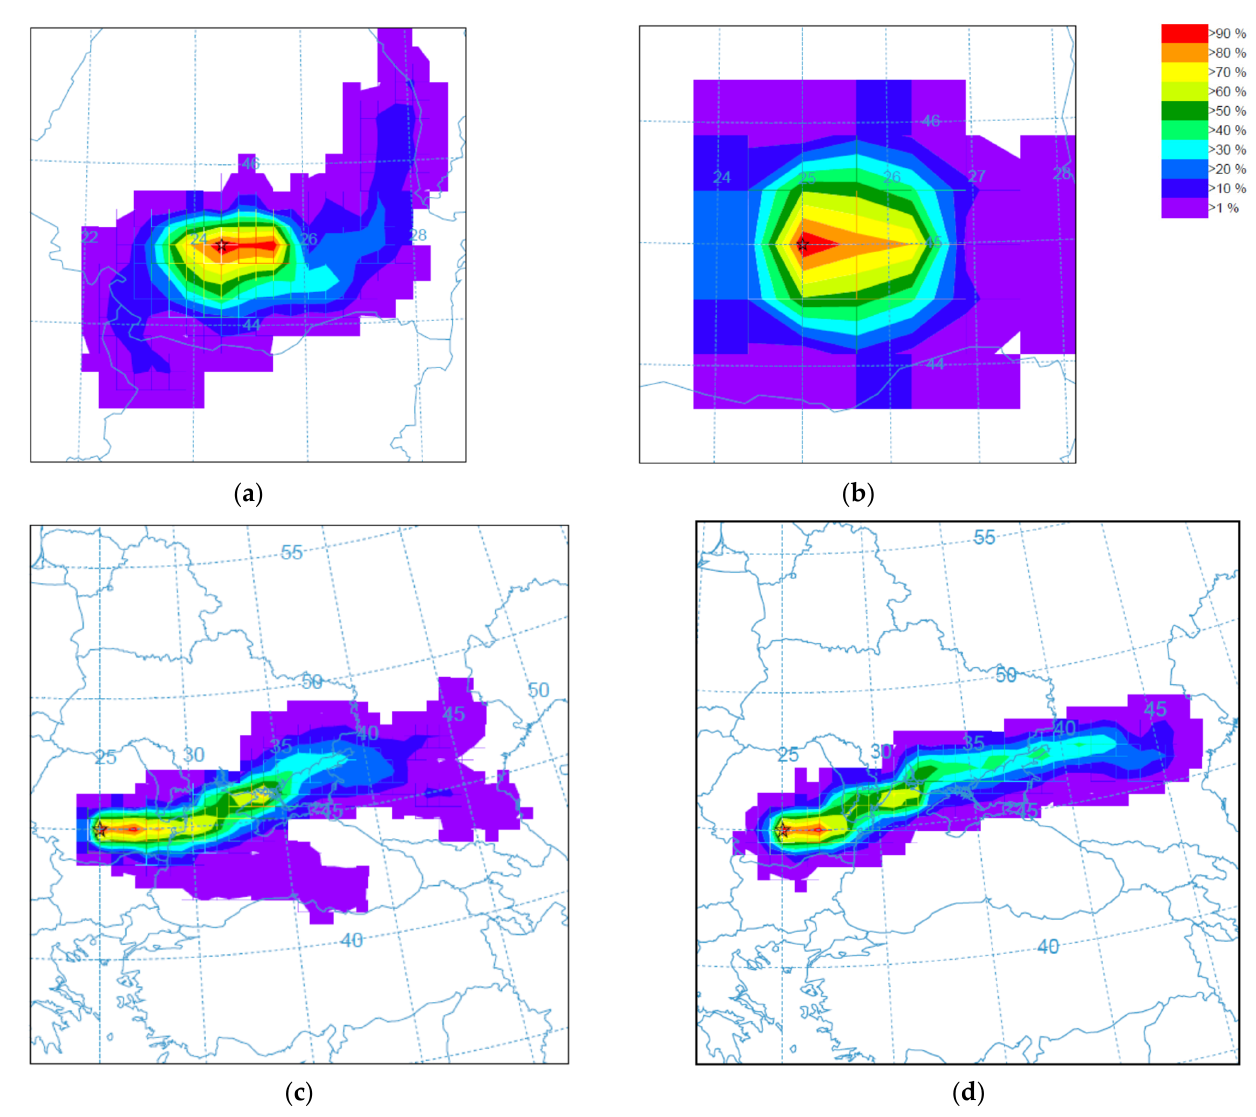
Figure 7. The NOOA HYSPLIT backward trajectory model using trajectory frequency option and GDAS1 meteorology: